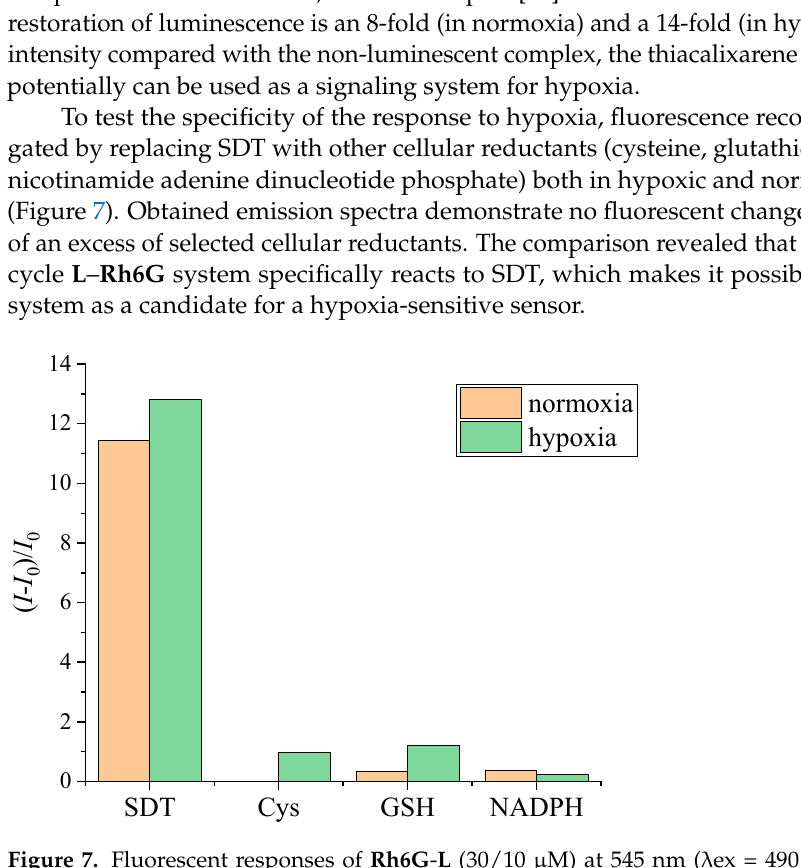
Figure 6. I 0 / I vs time for rhodamine dye-thiacalixarene L systems in the presence of SDT under normoxia and hypoxia. I 0 is the fluorescence intensity of the free dye. C (dye) = 1 μ M, C ( L ) = 1 μ M, C (SDT) = 100 μ M, PBS buffer (pH 7.4).